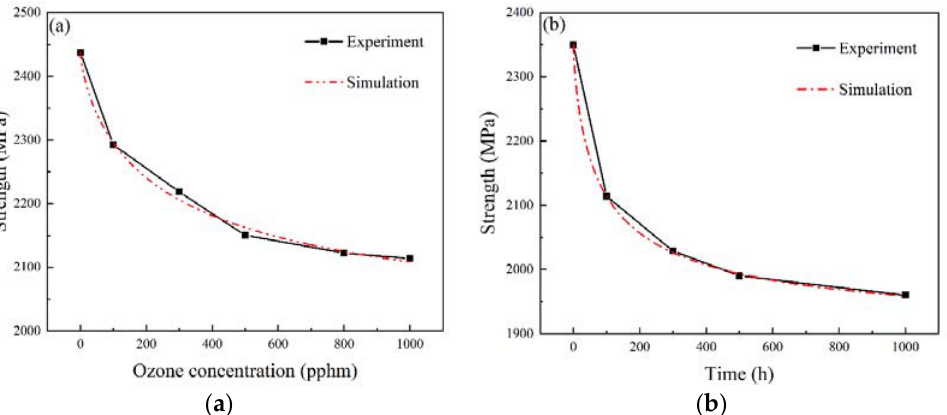
Figure 6. Correlation between the tensile strength of the Kevlar fiber and ozone concentration and exposure time: ( a ) Stress and ozone concentration, ( b ) Stress and ozone exposure time.